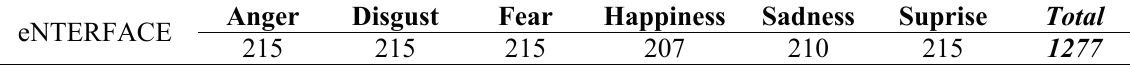
Table 4. Distribution of emotional sentences for eNTERFACE.